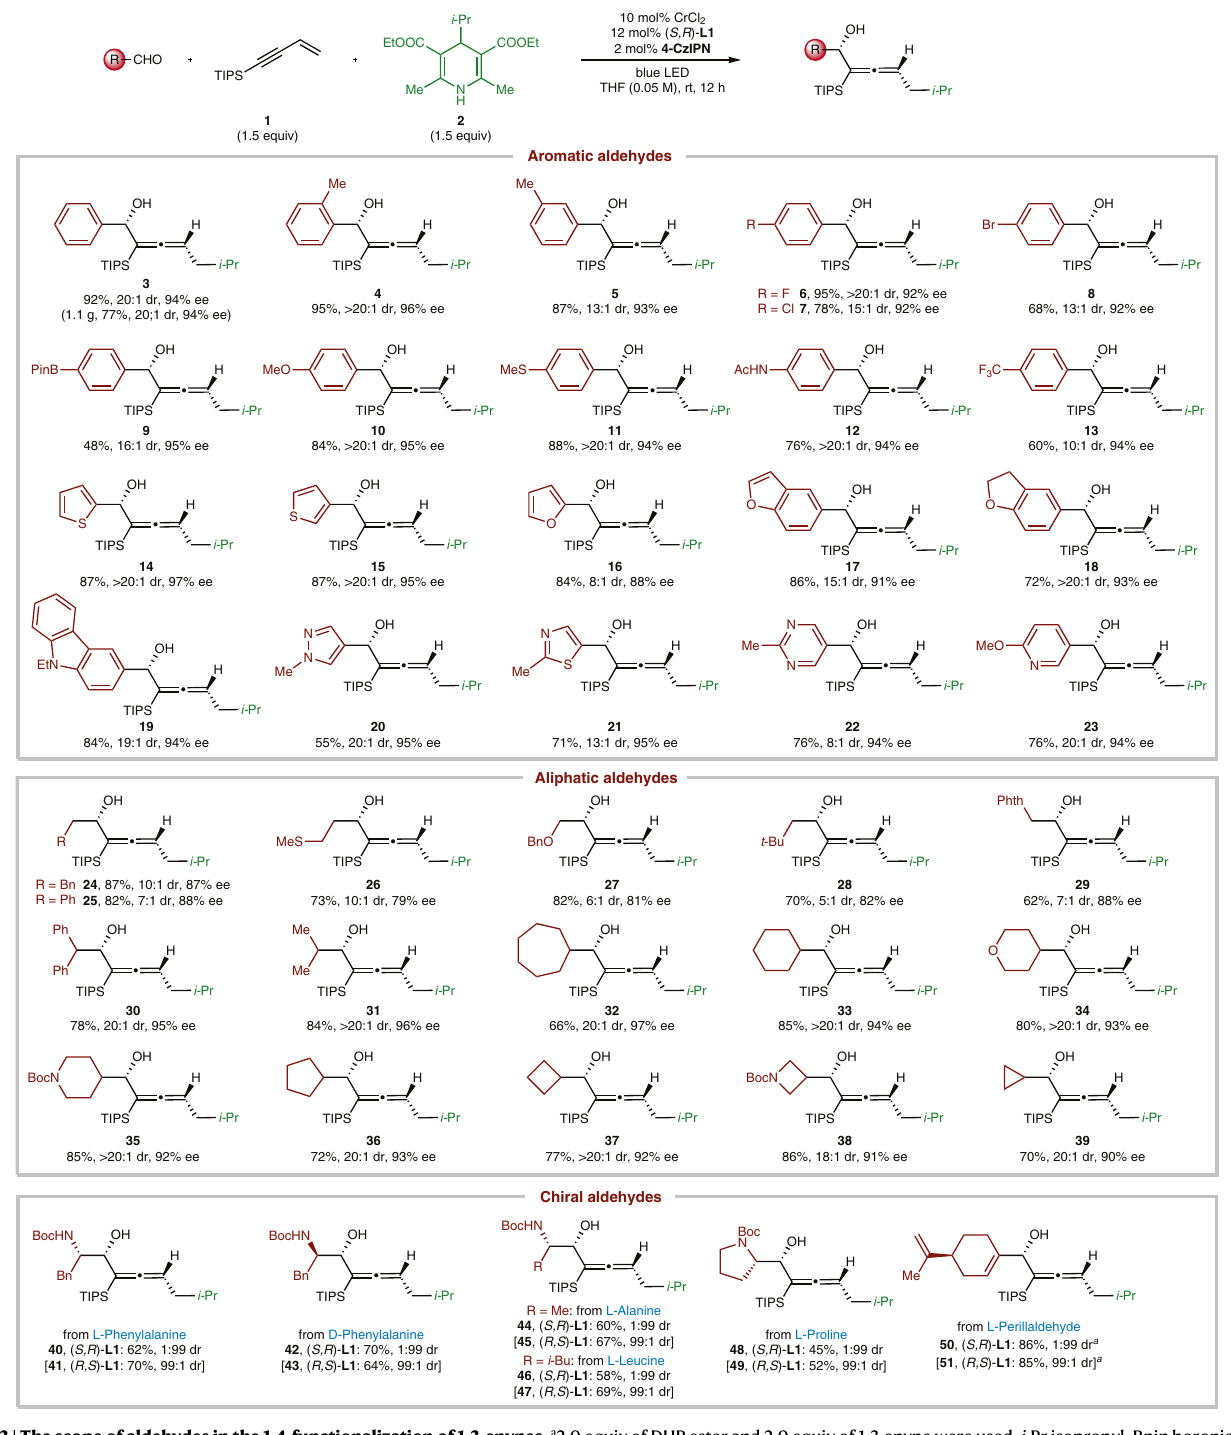
Fig.3|Thescopeofaldehydesinthe1,4-functionalizationof1,3-enynes. a 2.0equivofDHPesterand2.0equivof1,3-enynewereused. i- Prisopropyl,Bpinboronicacid pinacol ester, Ac